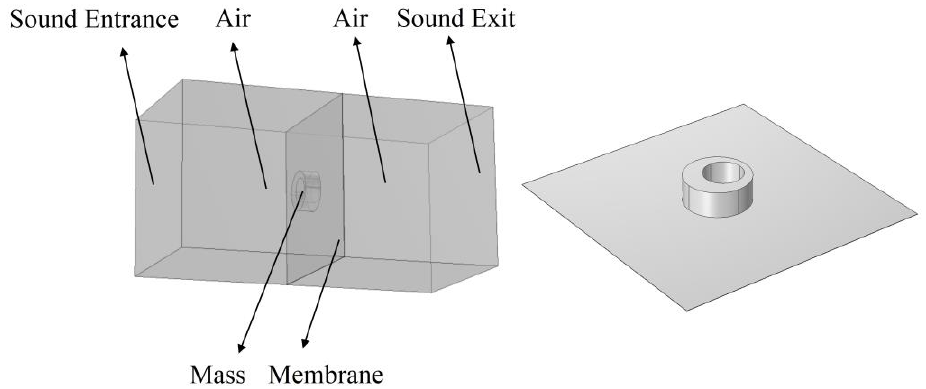
Figure 2. The 3D finite element model for the verification of the analytical model.